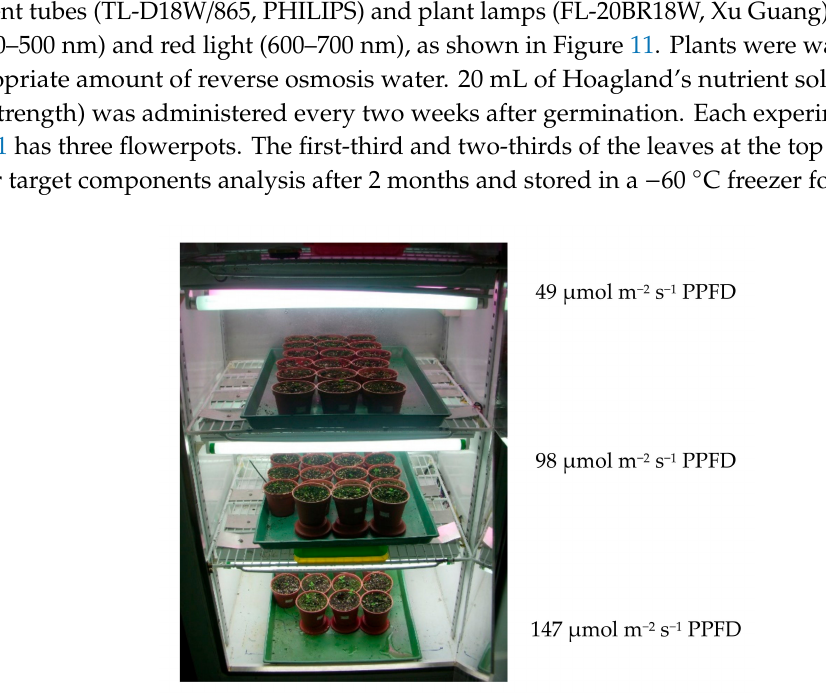
Figure 11. Growth conditions of St. John’s wort cultivated in growth chambers with light intensities of 49, 98, and 147 µ mol m − 2 s − 1 PPFD,